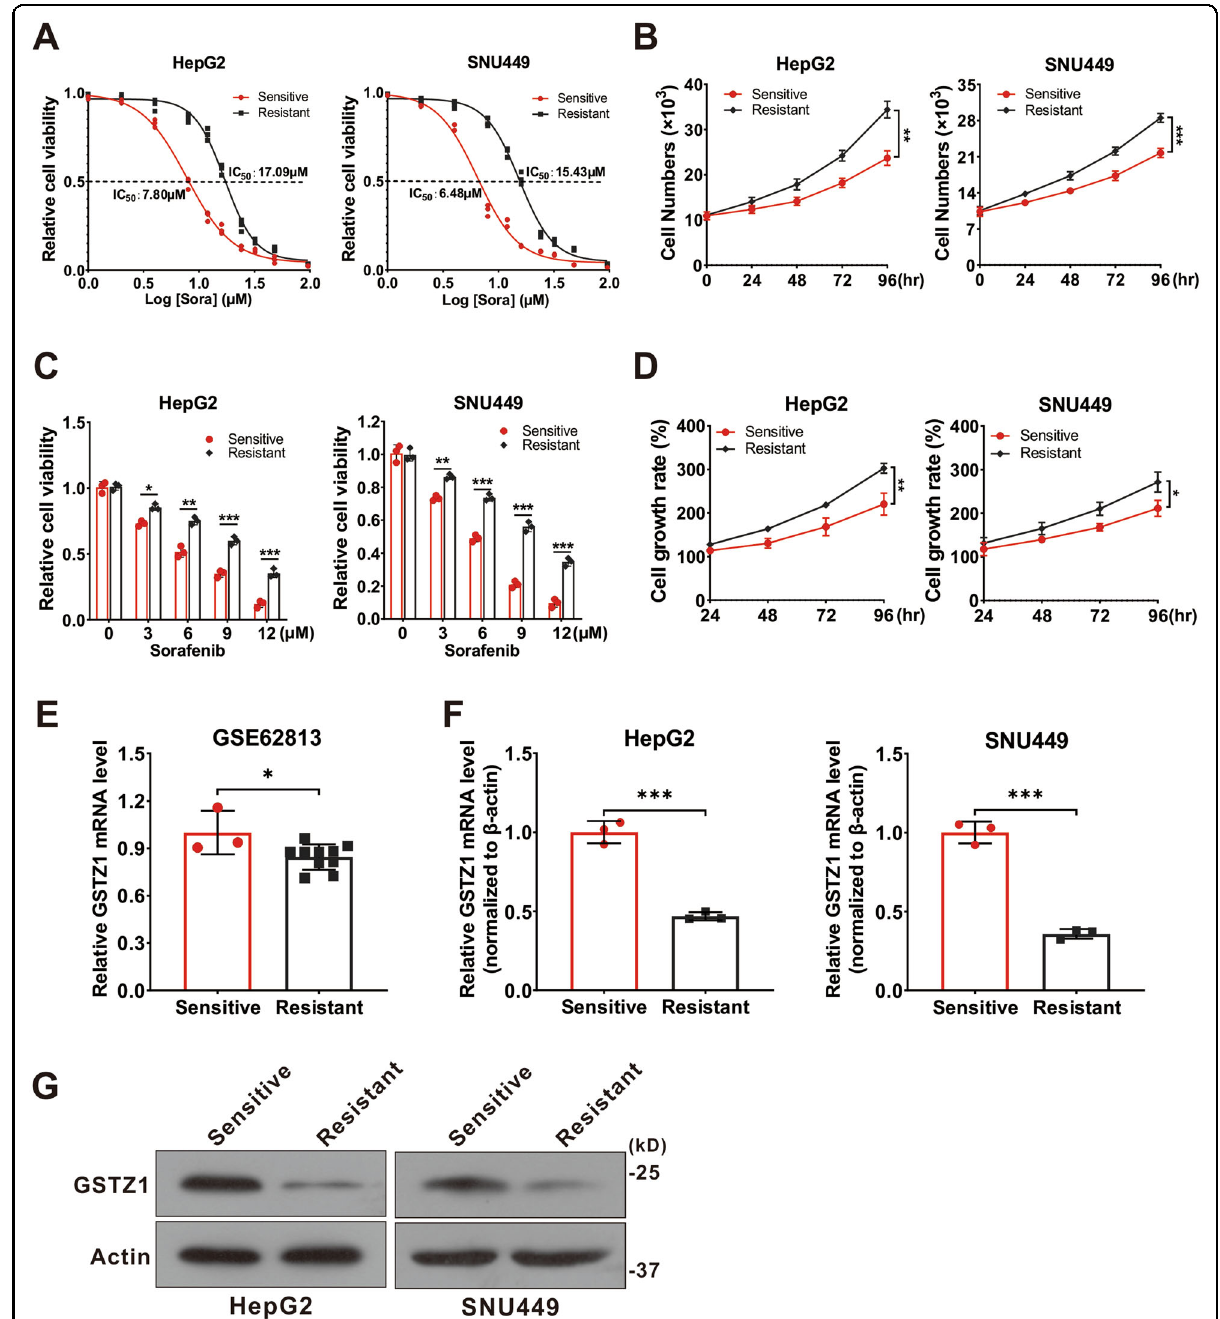
Fig. 1 GSTZ1 is downregulated in sorafenib-resistant HCC cells. A The IC 50 values of sorafenib-sensitive and sorafenib-resistant HCC cells treated with sorafenib. B Cell growth curve. C These sorafenib-sensitive and sorafenib-resistant HCCs (HepG2, SNU449) were treated with indicated concentrations of sorafenib for 24 h, and cell viability was assayed using the CCK-8 assay. D Cell growth rate. E GSTZ1 mRNA level in GEO dataset GSE62813. Sorafenib-sensitive HepG2 cells ( n = 3) and sorafenib-resistant HepG2 cells ( n = 10). F – G mRNA and protein levels of GSTZ1 in sorafenib- sensitive and -resistant cells. For western blotting, 50 μ g protein was loaded per well. HCC hepatocellular carcinoma. Values represent the mean ± standard deviation (SD) ( n = 3). The qRT-PCR data determined from three independent experiments. * p < 0.05, ** p < 0.01, *** p < 0.001, Student ’ s t -test (two